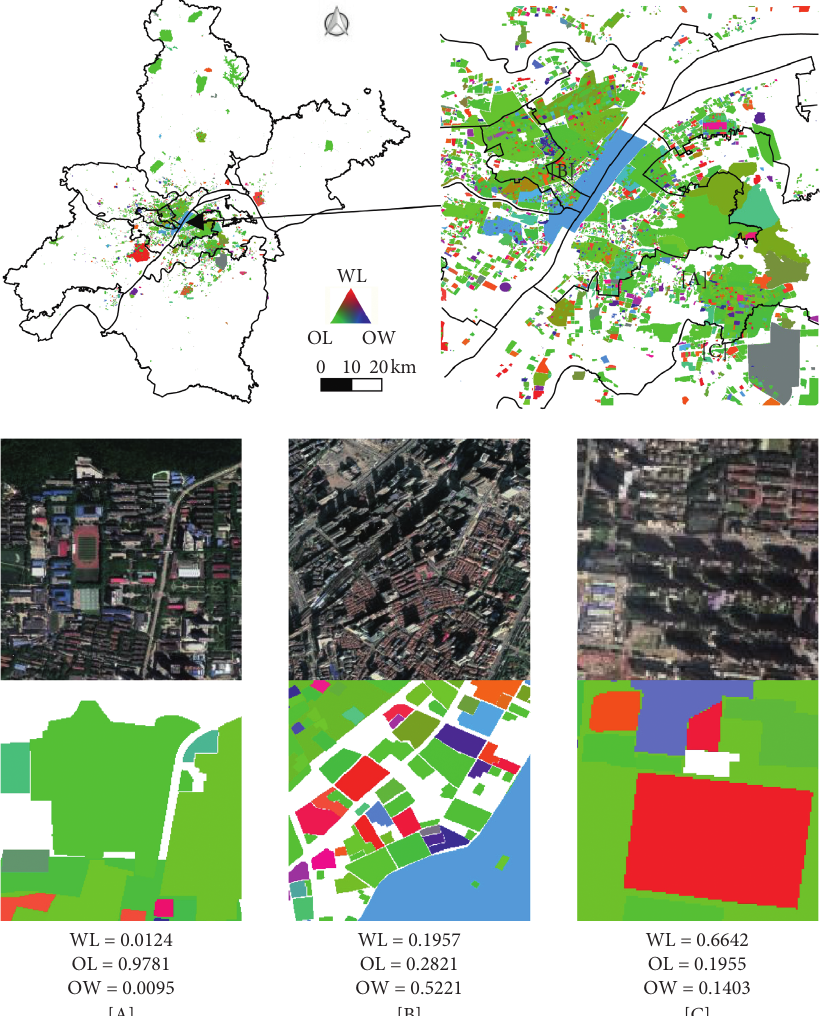
Figure 9: Fitting results of the jobs-housing model in Wuhan: (A) China University of Geosciences, (B) Hankou River Beach, and (C) Guanggu Software